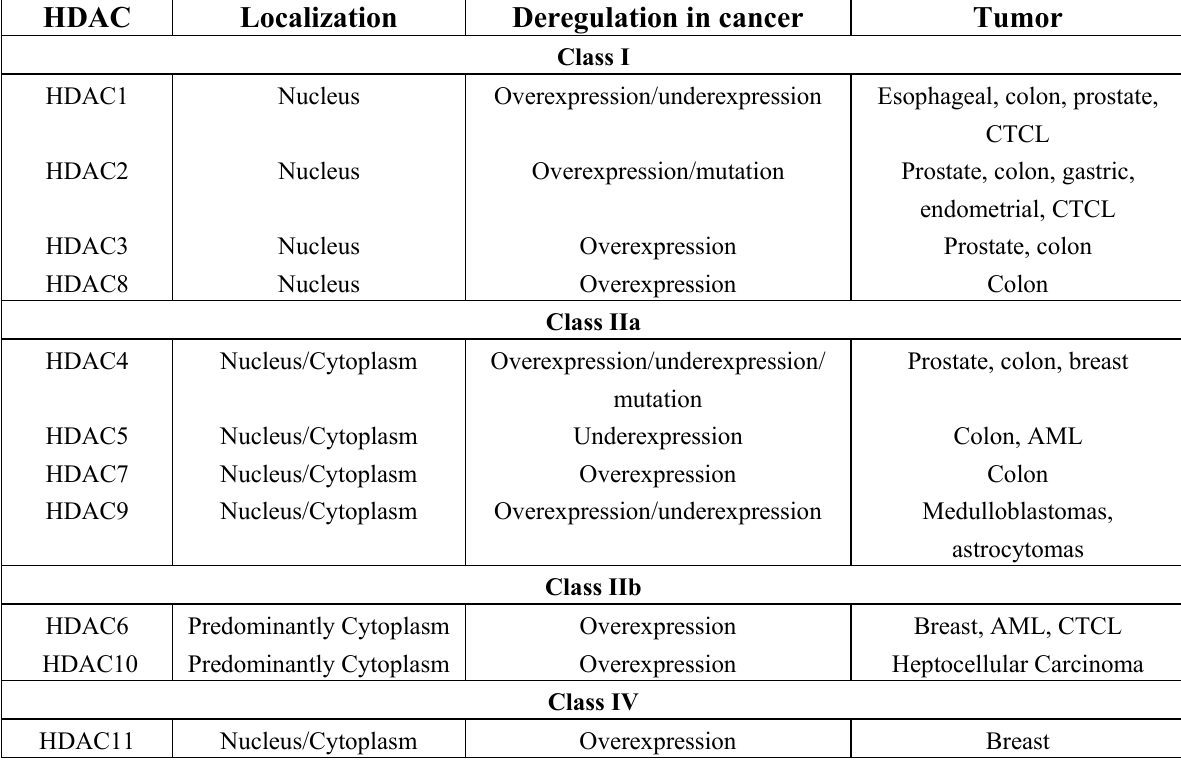
Table 1. Class I/II and IV HDACs; cellular localization and cancer